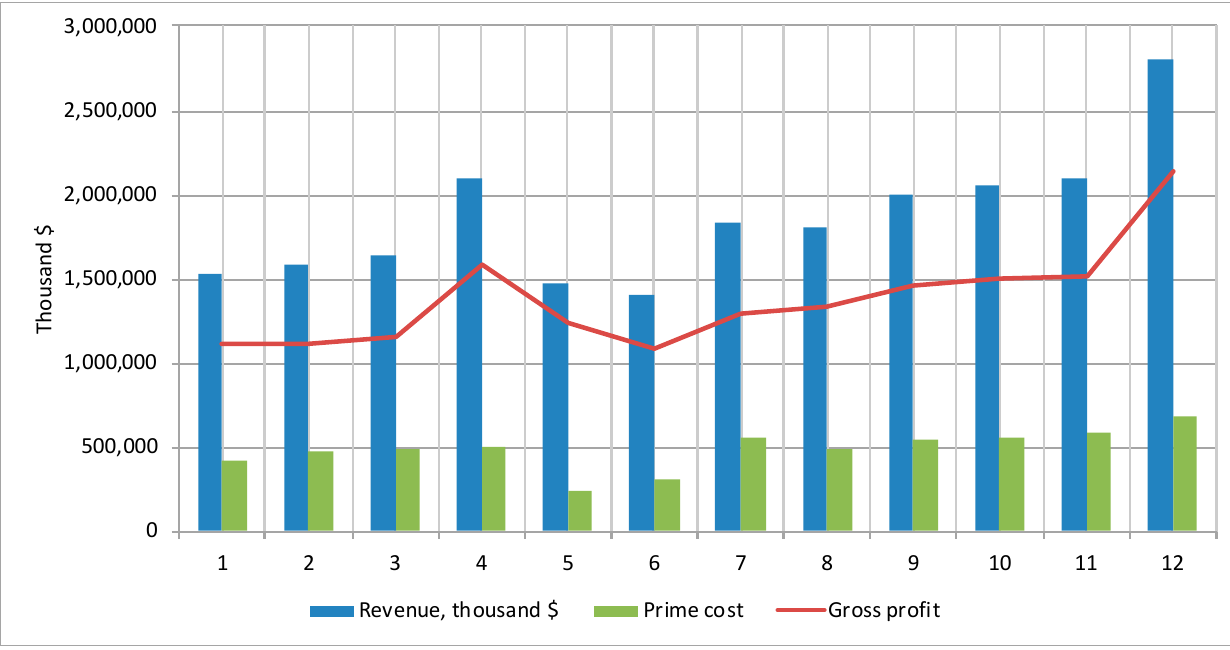
Figure 4. Results of forecasting financial indicators in the event of a technogenic risk at P = 1. The annual revenue will amount to USD 22,349.4 million (instead of USD 23,008.3 million) and the gross profit of USD 5847.6 million (instead of USD 6029.4 million) due to the interruption of the DC operation. Thus, the damage from the occurrence of a risky event will amount to USD 181.75